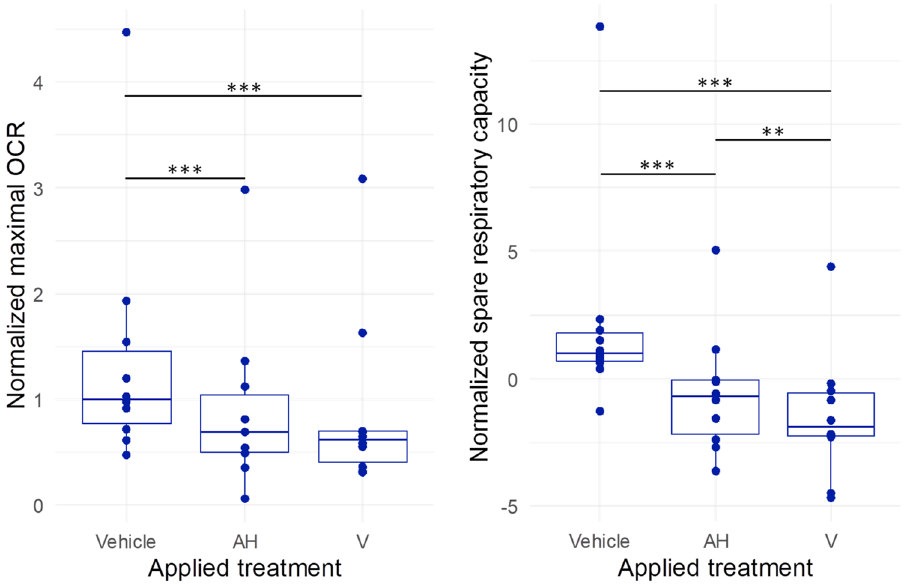
Figure 4. Measure of maximal OCR (left panel) and spare respiratory capacity (right panel) of PBMCs’s mitochondria exposed 4 h with Al-based treatments. AH, Aluminum oxyhydroxide. V, Whole vaccine